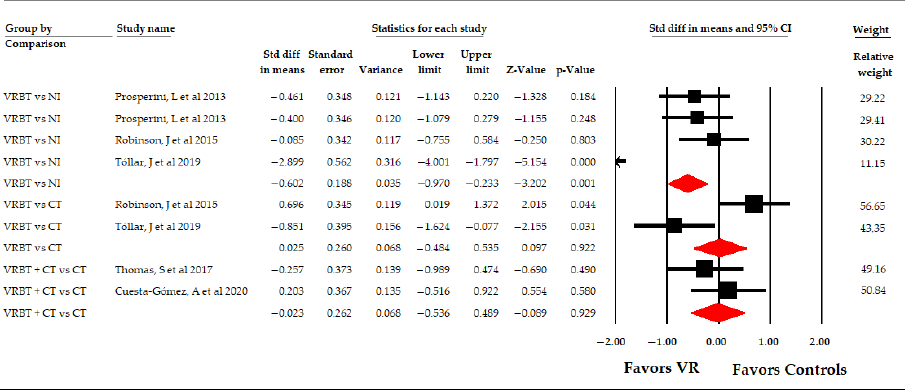
Figure 5. Subgroup Analysis of the Effect of Virtual Reality on the Impact of Multiple Sclerosis Ac- cording to Specific Comparisons.